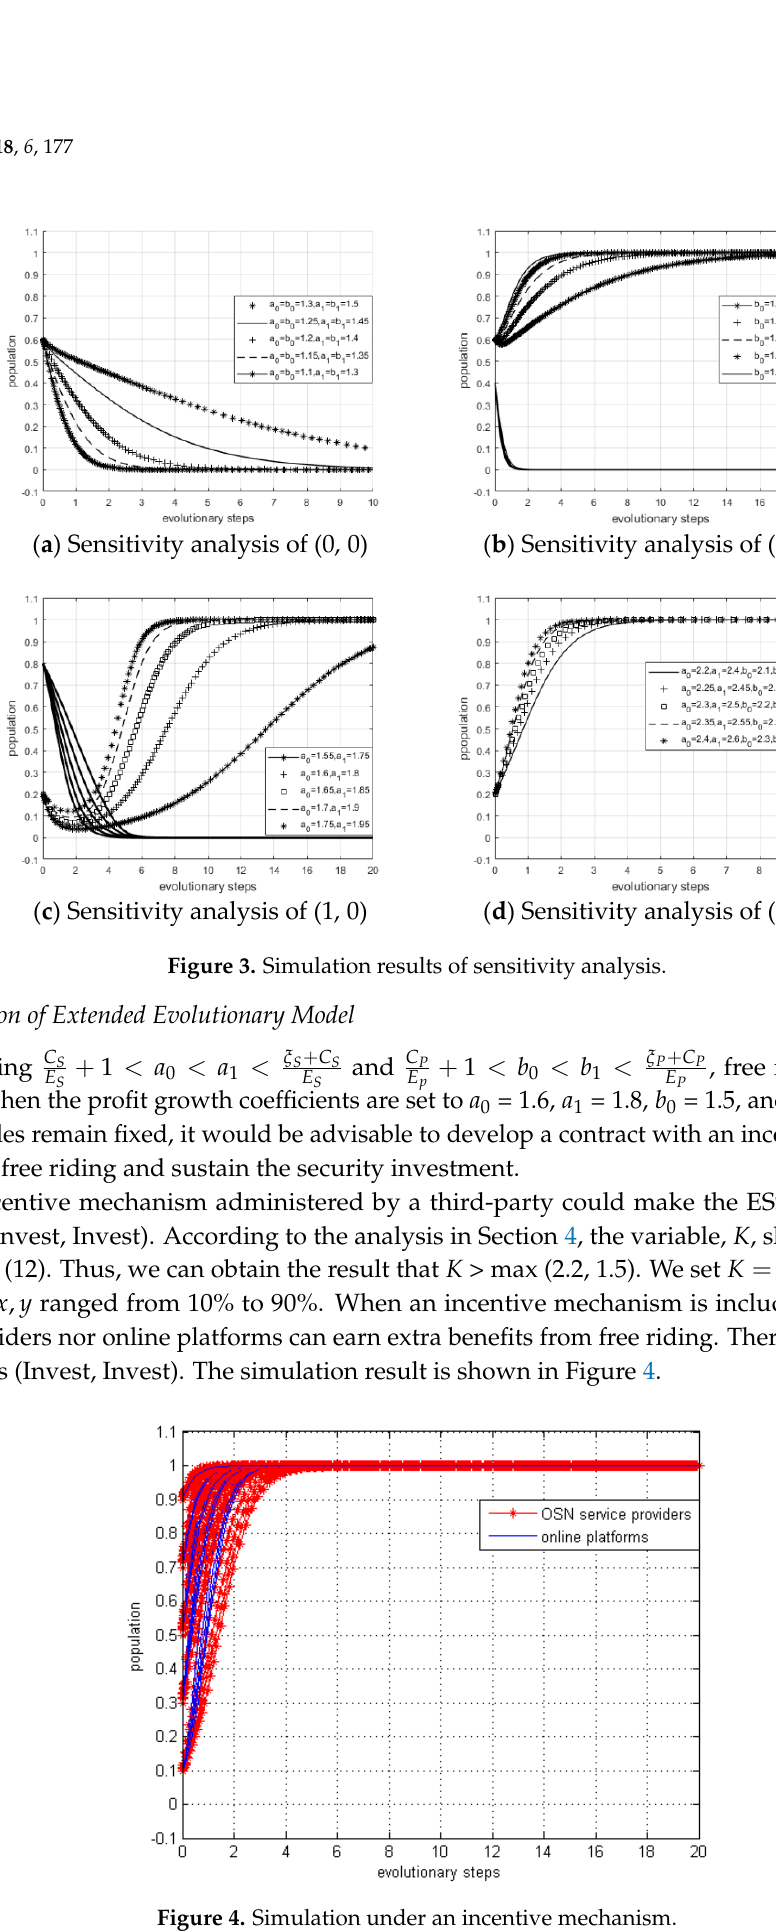
Figure 4. Simulation under an incentive mechanism.